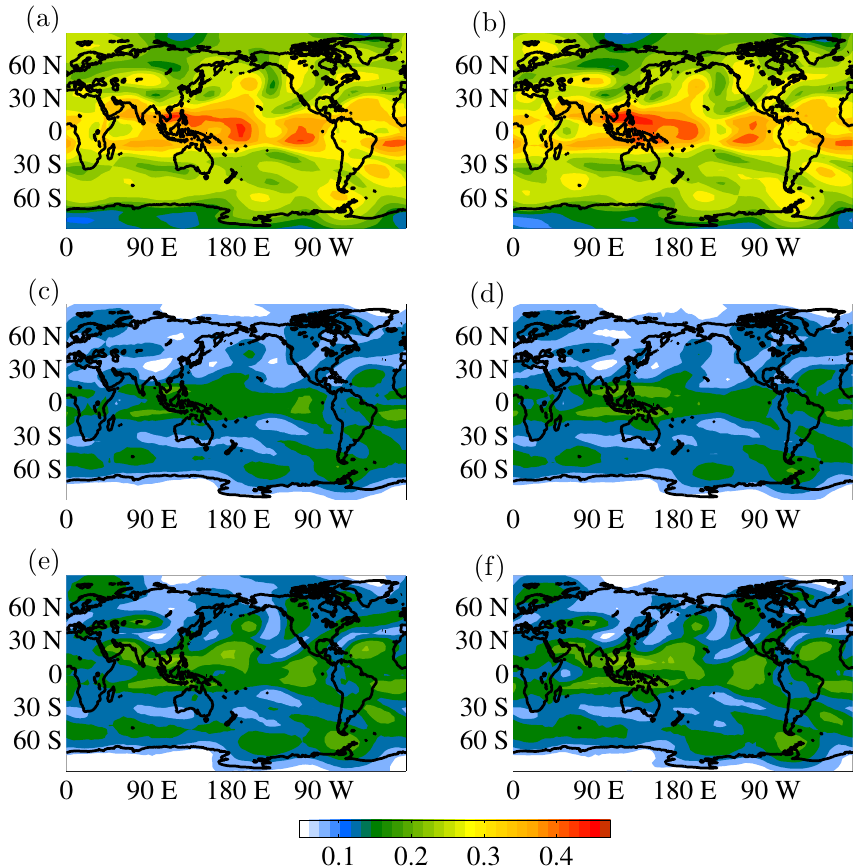
Figure 11. AWC maps of the ICTP-AGCM internal variability. The networks are built with PC (1901–1953) (a) and (1954–2006) (b) , BP methodology with 1t =1 (1901–1953) (c) and (1954–2006) (d) , and BP with 1t =4 (1901–1953) (e) and (1954–2006) (f) .